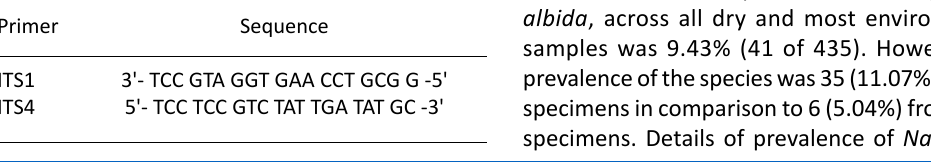
Table 2. Sequence of primers used for PCR amplification